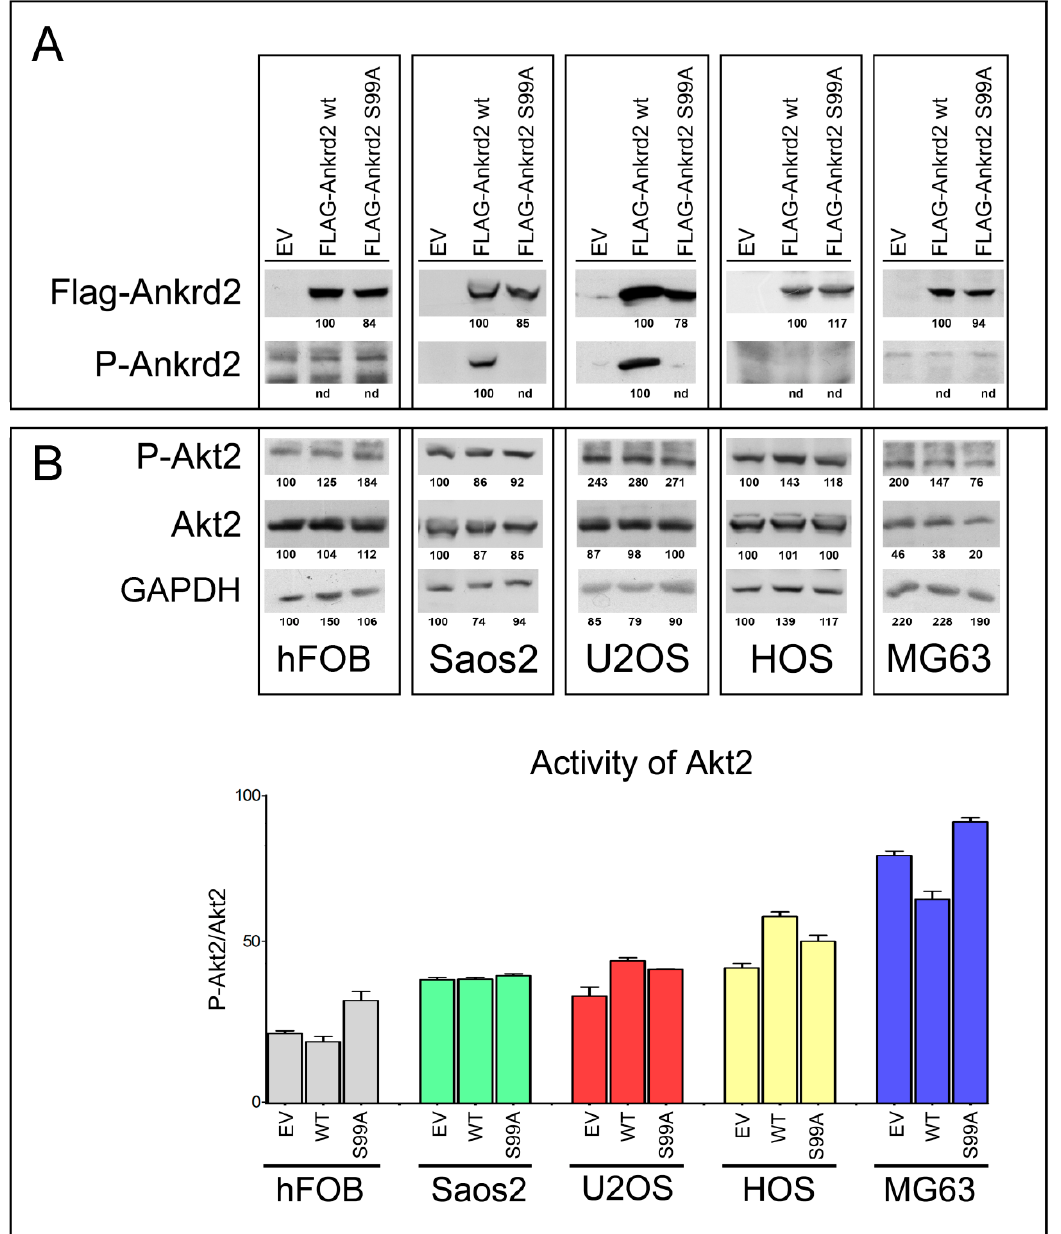
Figure 2. Characterization of OS cell lines stably expressing Ankrd2 wt and mutant S99A. ( A ) Total cell lysates obtained from clones of hFOB, Saos2, U2OS, HOS and MG63 overexpressing Flag-tagged Ankrd2 forms (wt and S99A), or transfected with empty vector (EV), were assayed for the expression of ectopic Ankrd2, by the use of an antibody against its Flag-tag, as well as the phosphorylation profile of its S99 [P-Ankrd2, phospho-Ankrd2 (Ser99)]. ( B ) Fifty µ g of total lysates from the same samples of A) were analyzed with the indicated antibodies [P-Akt2, phospho-Akt2 (Ser474)]. The activation status of Akt2 is presented as the ratio between the values of densitometric analysis of the bands of anti-p-Akt2 against those of anti-Akt2. Blots represent the best of four